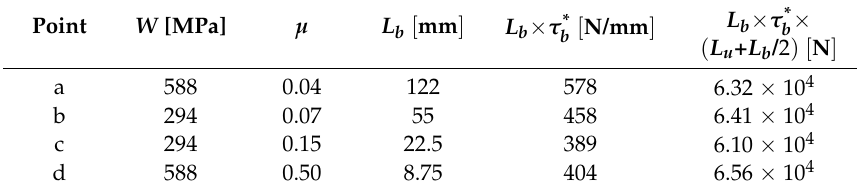
× ( L u + L ) when ∆ = 12 µ m for a, b, c, d in Figure 5. and L b × τ ∗ b /2 b b